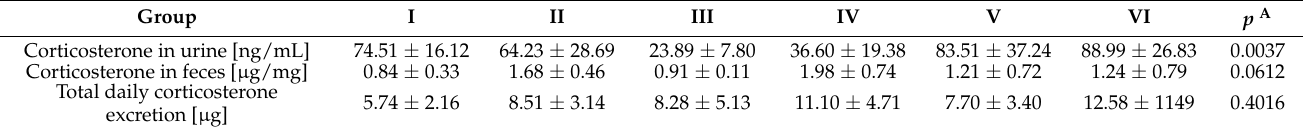
Table 4. Mean corticosterone values by